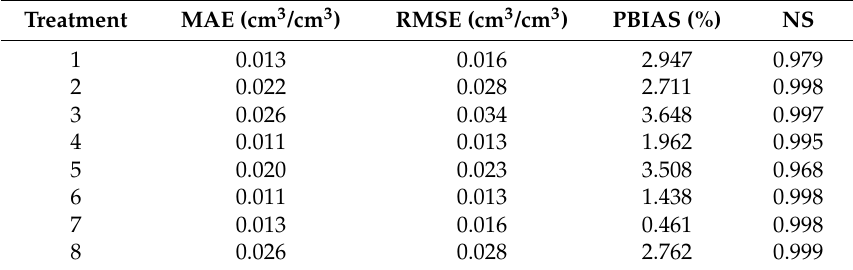
Table 3. Correlation between simulated and measured SWC